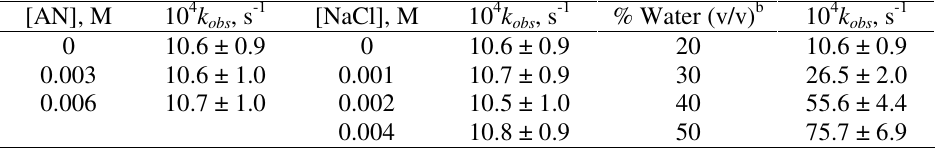
Table 3 . Influence of added acrylonitrile (AN), NaCl and solvent composition on reaction rate for the oxidation of PTAA with NCSA a